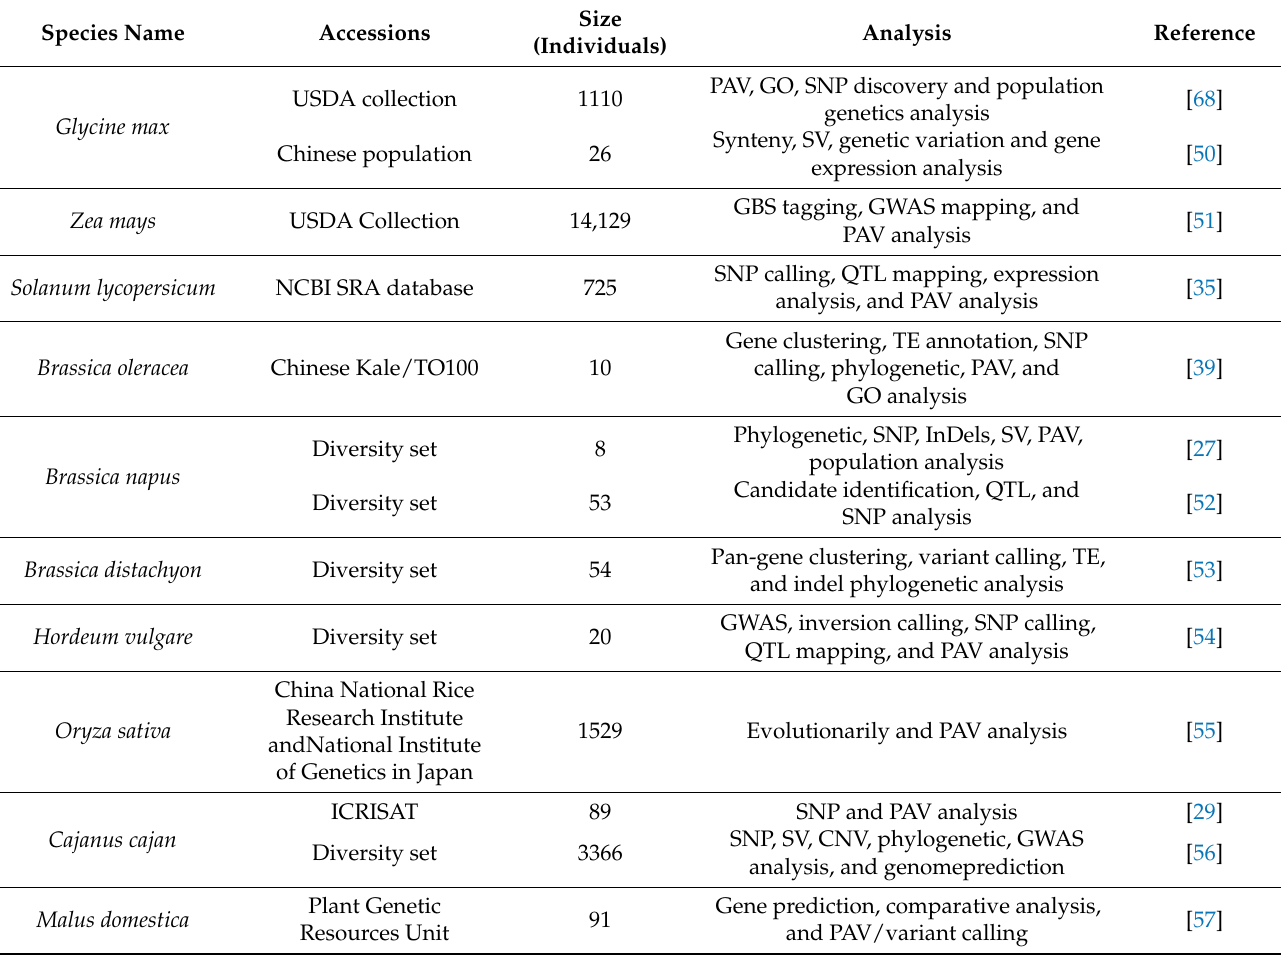
Table 1. A summary of plant pangenome